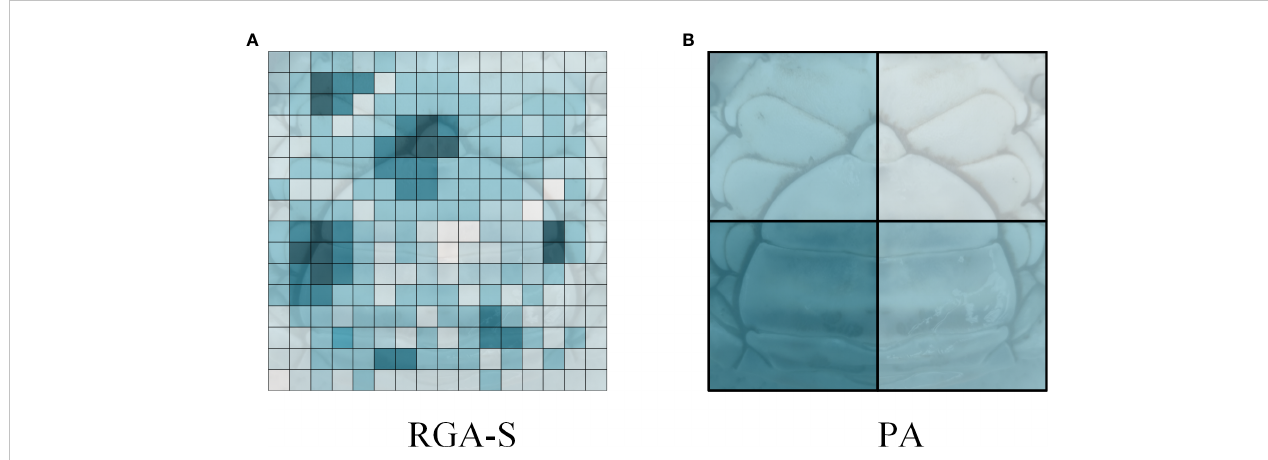
FIGURE 10 Visualization of attention mechanisms. (A) visualization of RGA-S (B) visualization of our part attention (PA)